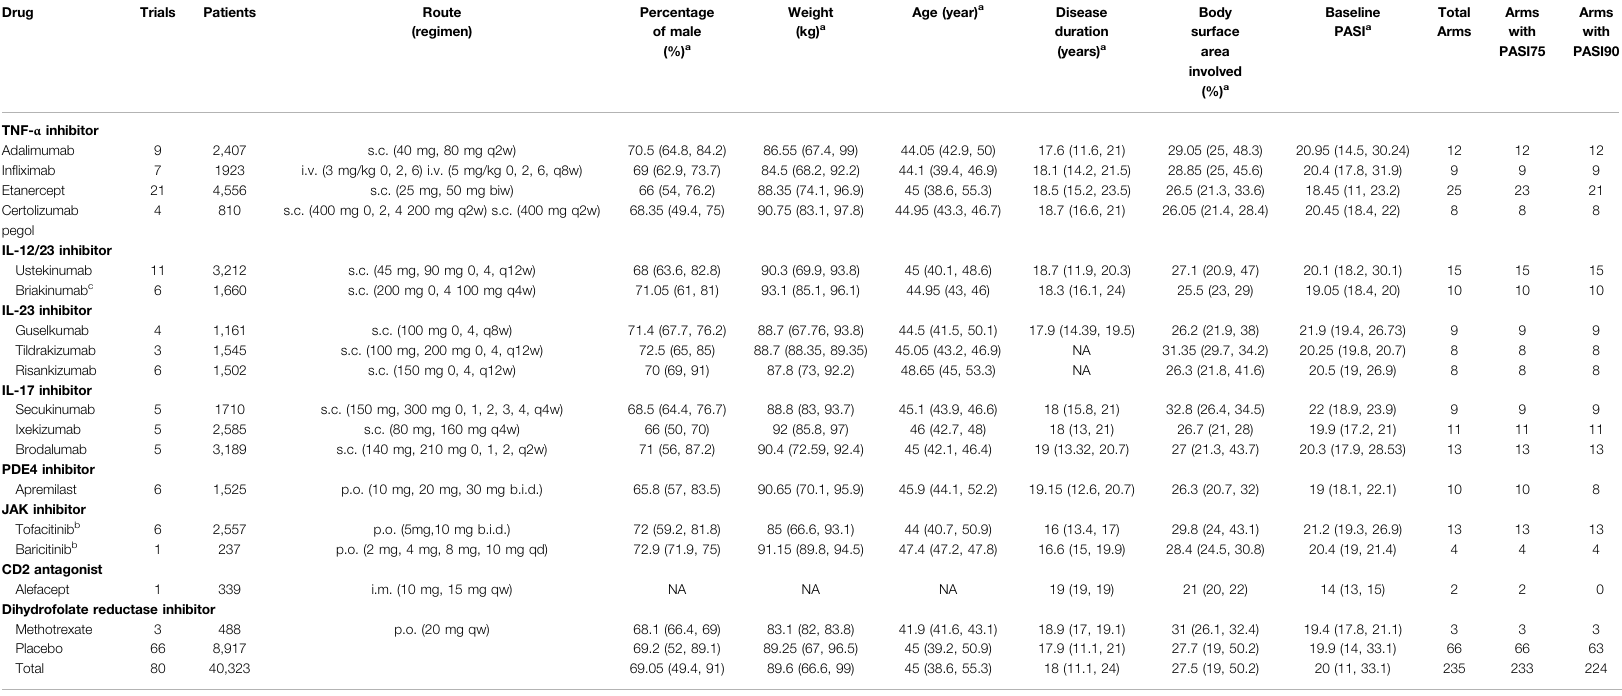
TABLE 1 | Summary of available information for each drug in the analysis.